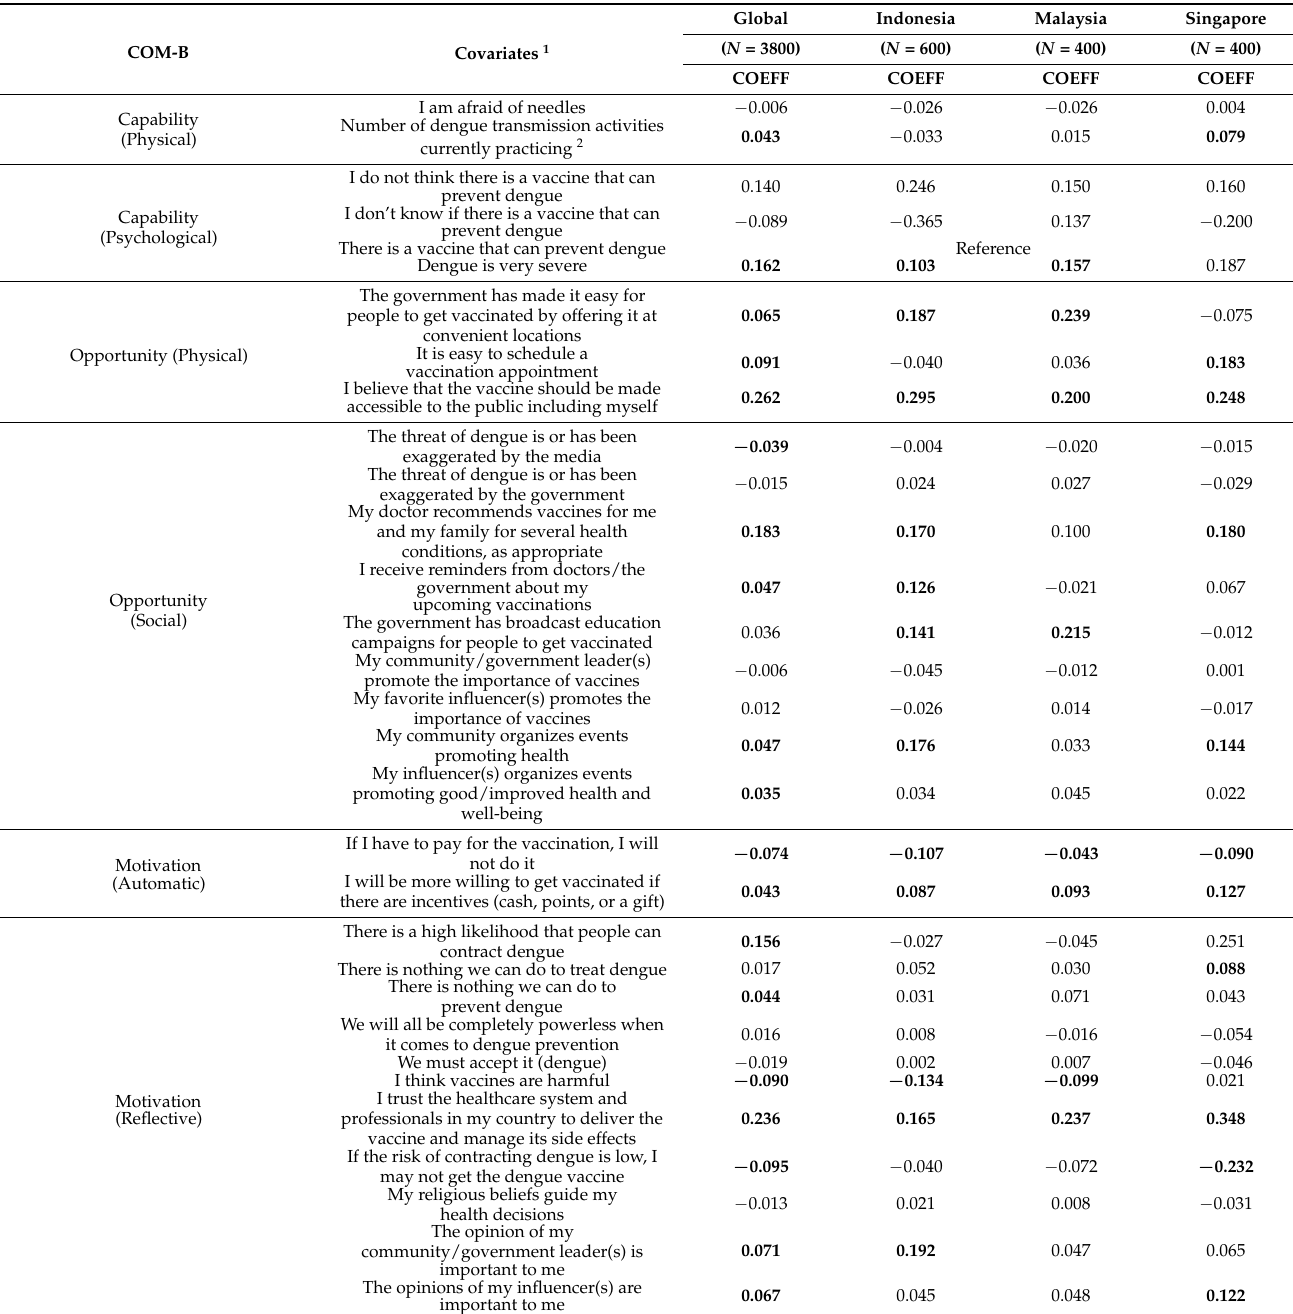
Table 4. Capability, Opportunity, Motivation factors associated with willingness to vaccinate against dengue globally and by country in Asia